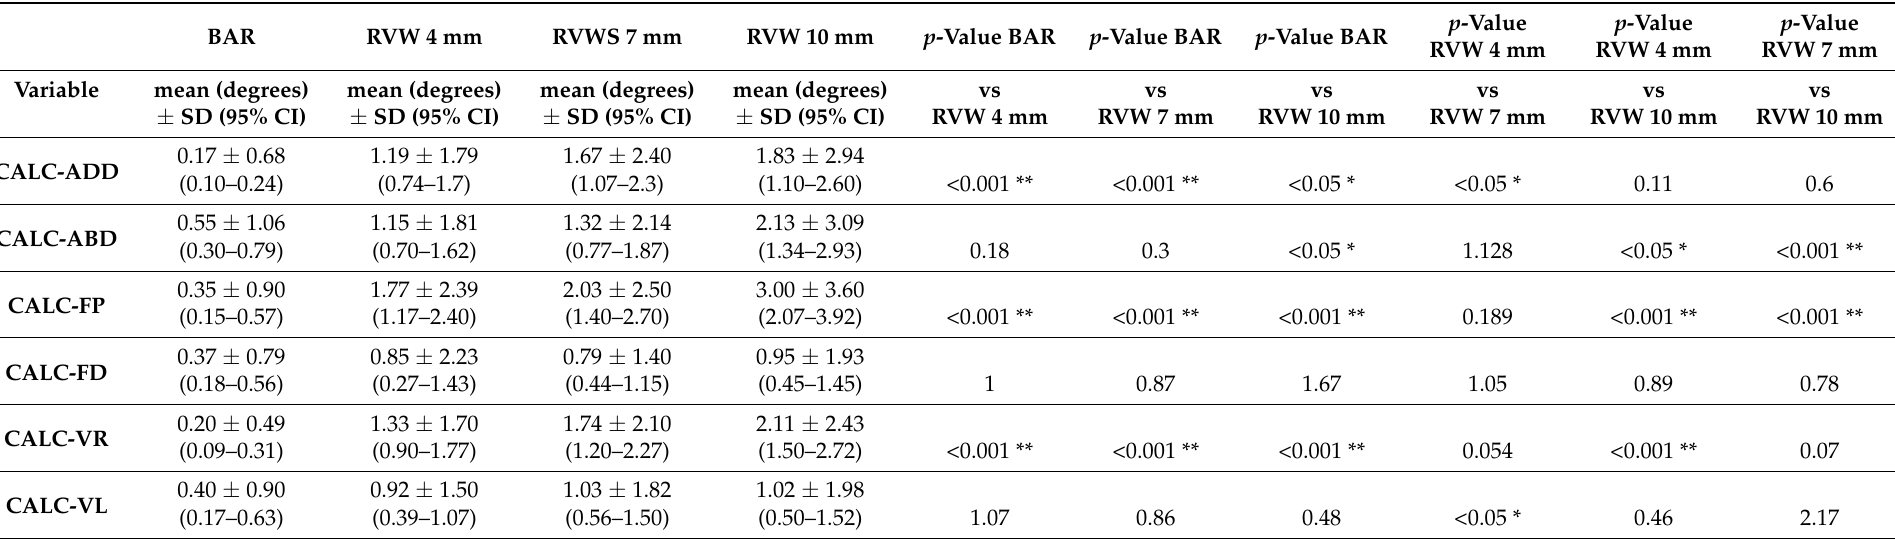
Table 6. The calcaneus sensor degrees of motion result in barefoot condition and with 4 mm, 7 mm, and 10 mm rearfoot varus